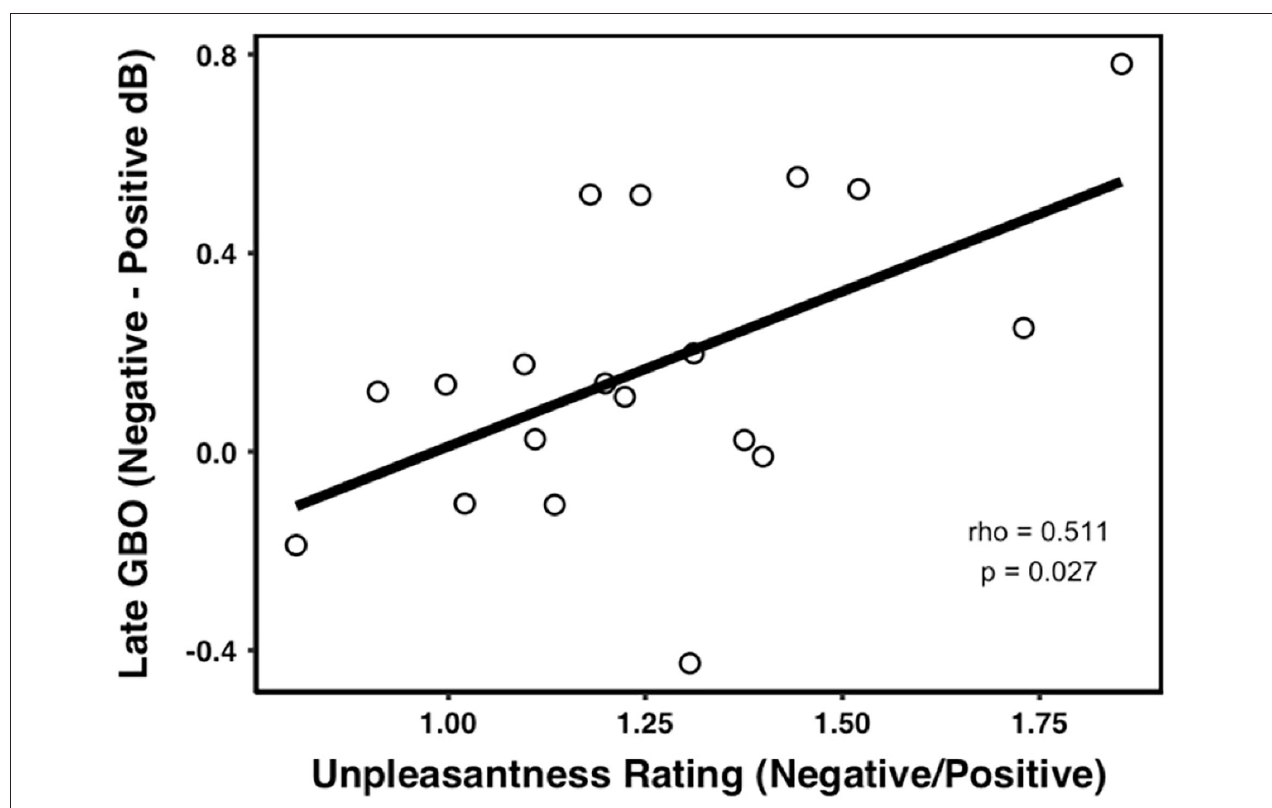
FIGURE 5 | Correlations between the late GBOs and pain ratings. The amplitude of the late GBO was positively correlated with the unpleasantness rating in the negative prime condition compared with the positive prime.